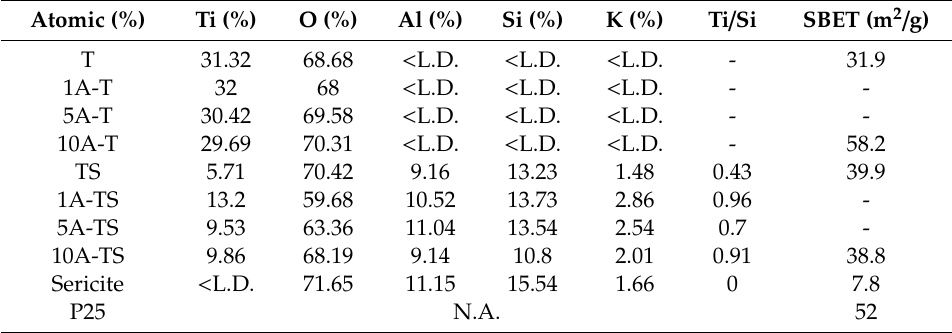
Table 2. EDS and BET analysis of various photocatalysts.